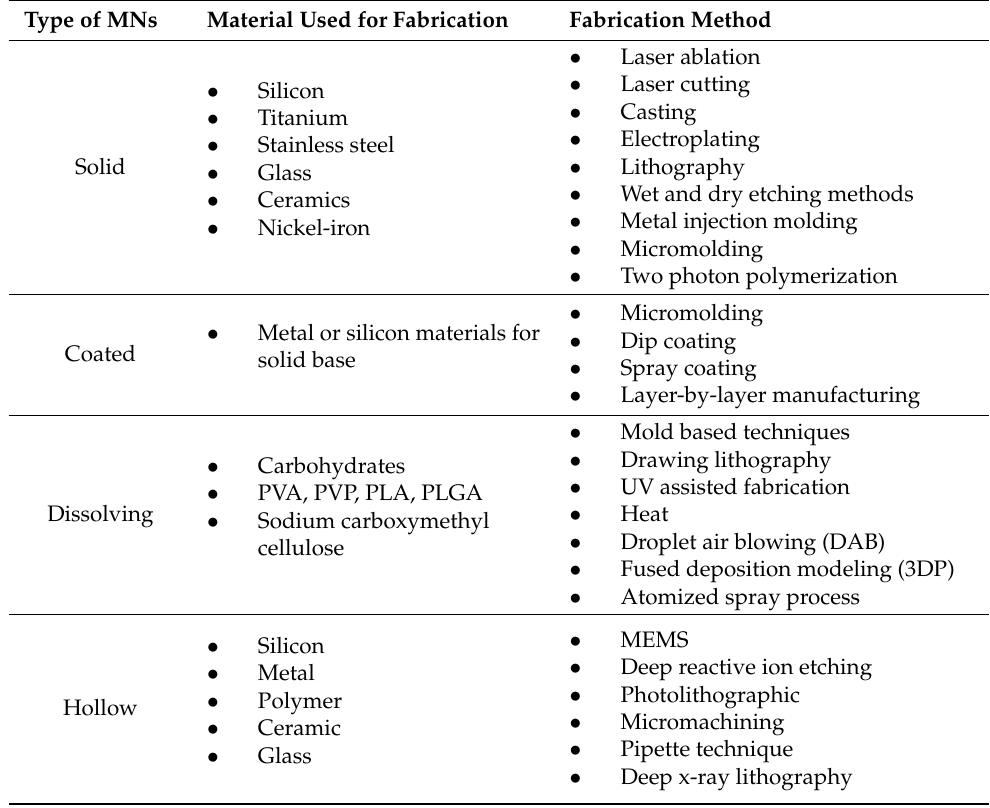
Table 1. Fabrication methods and materials of different